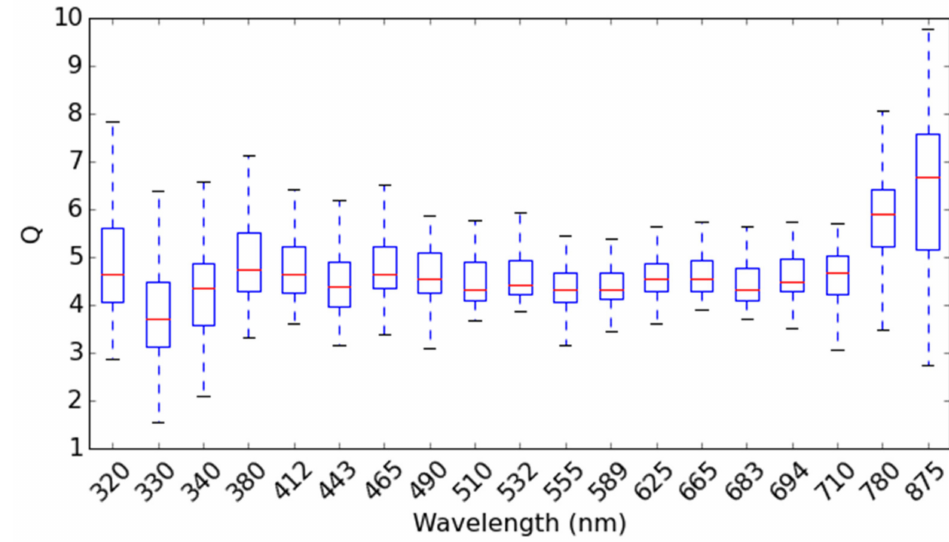
Figure 4. Statistics of the Q factor measured by